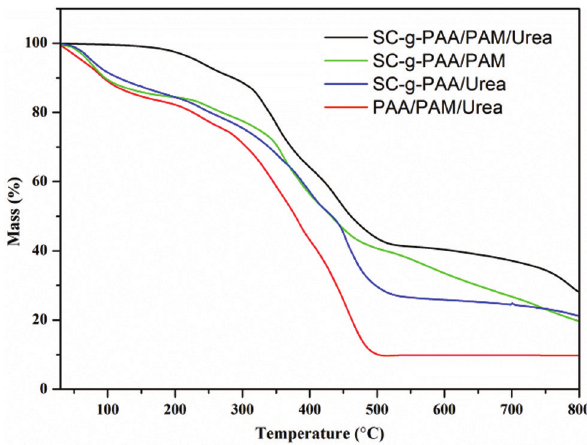
Figure 6: TGA curves of SC-g-PAA/PAM/Urea, SC-g-PAA/PAM, SC-g-PAA/Urea and PAA/PAM/Urea.